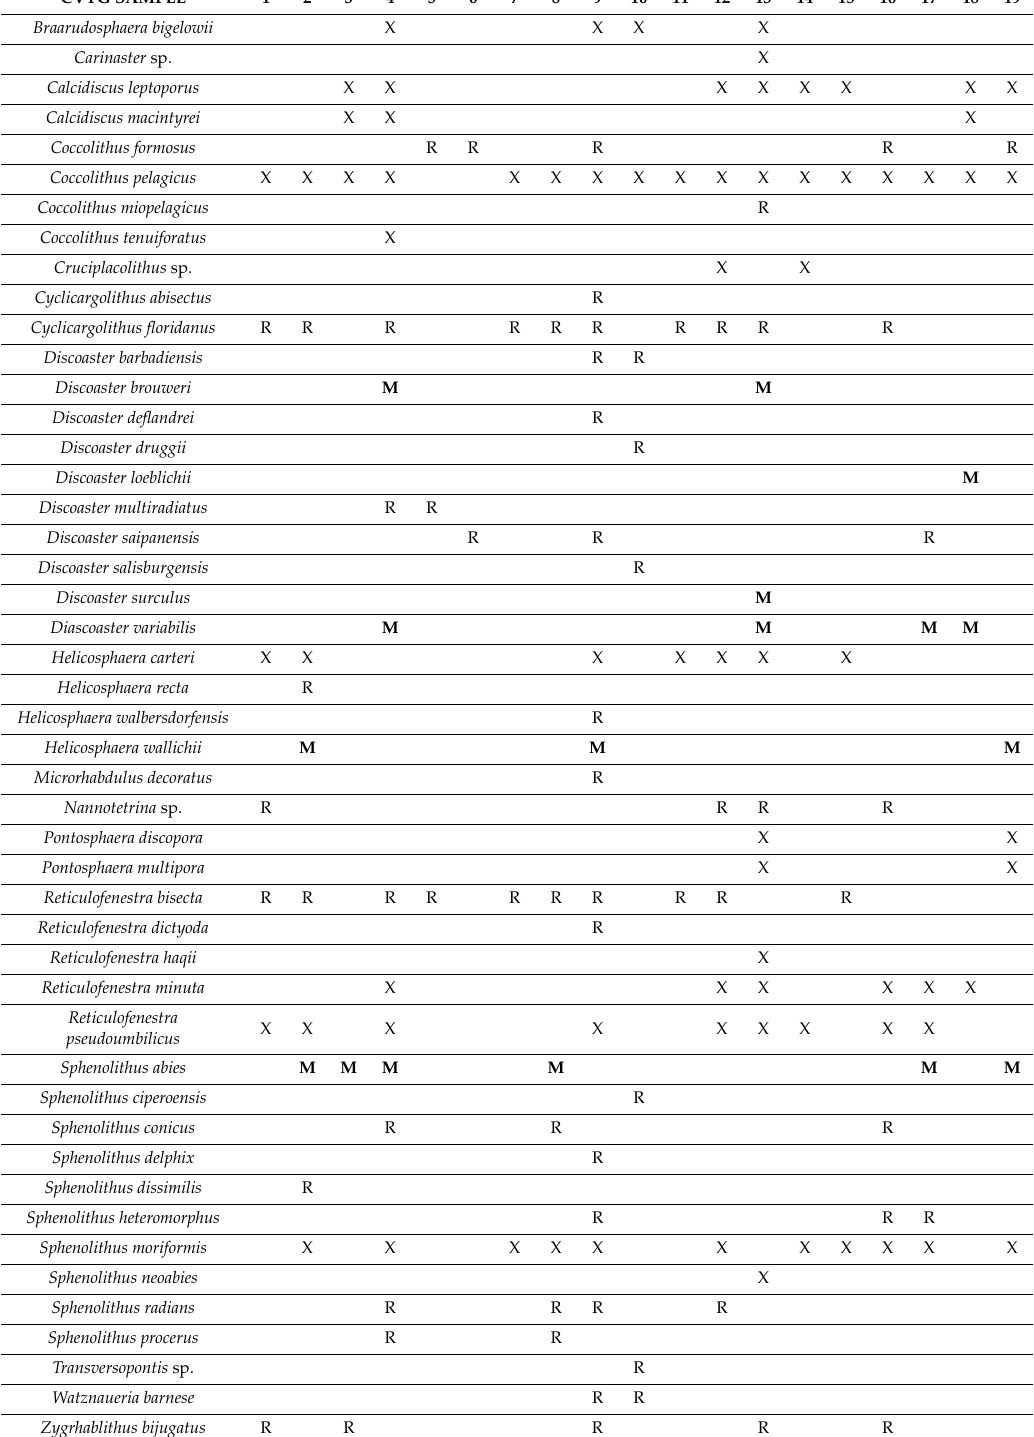
Table 1. Summary of biostratigraphic data (calcareous nannofossils). X: occurrence of specimen; R: reworked specimen; M: marker